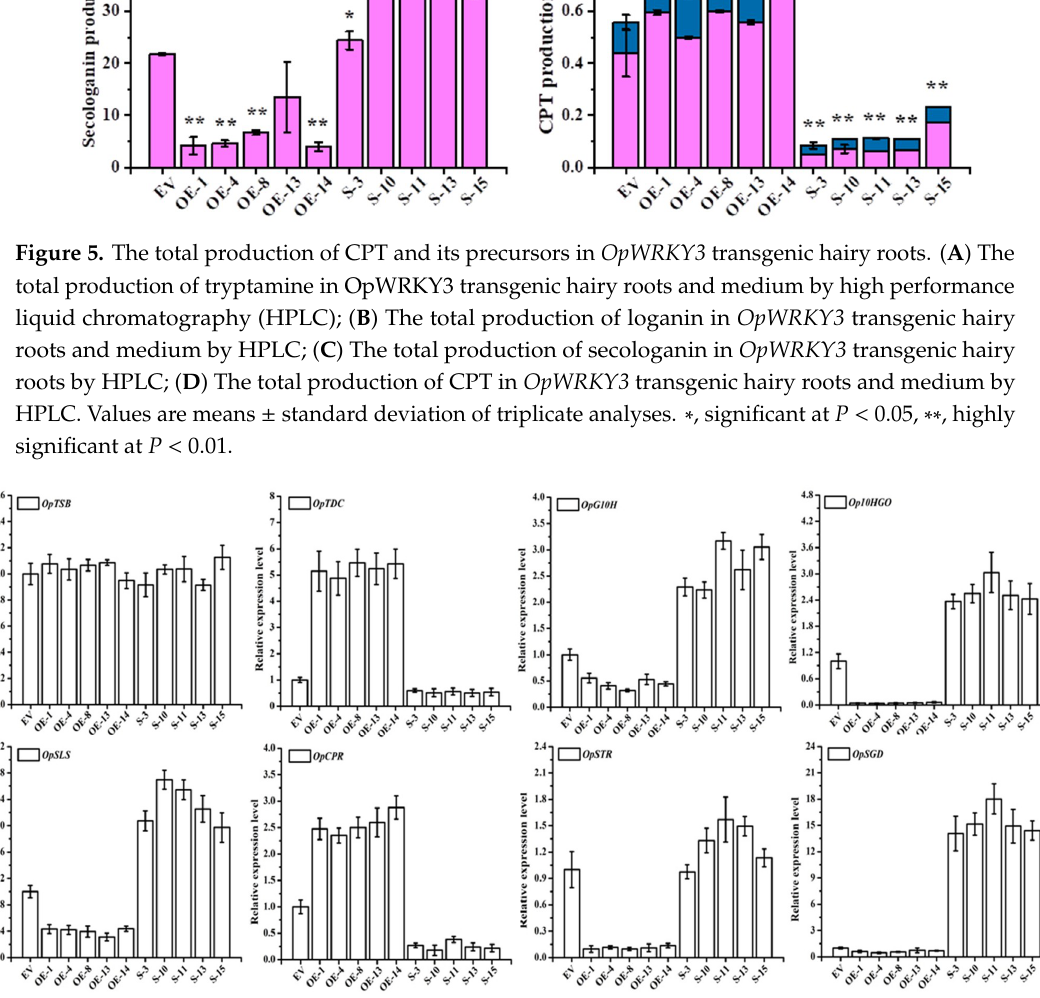
Figure 6. Relative expression levels of selected genes in OpWRKY3 transgenic hairy roots. Expression levels of these genes were normalized to the empty vector control line. The actin gene was used as an internal control. Values are means ± standard deviation of triplicate analyses. OpTSB , OpTDC , OpG10H , Op10HGO , OpSLS , OpCPR , OpSTR , and OpSGD genes are involved in camptothecin biosynthesis.